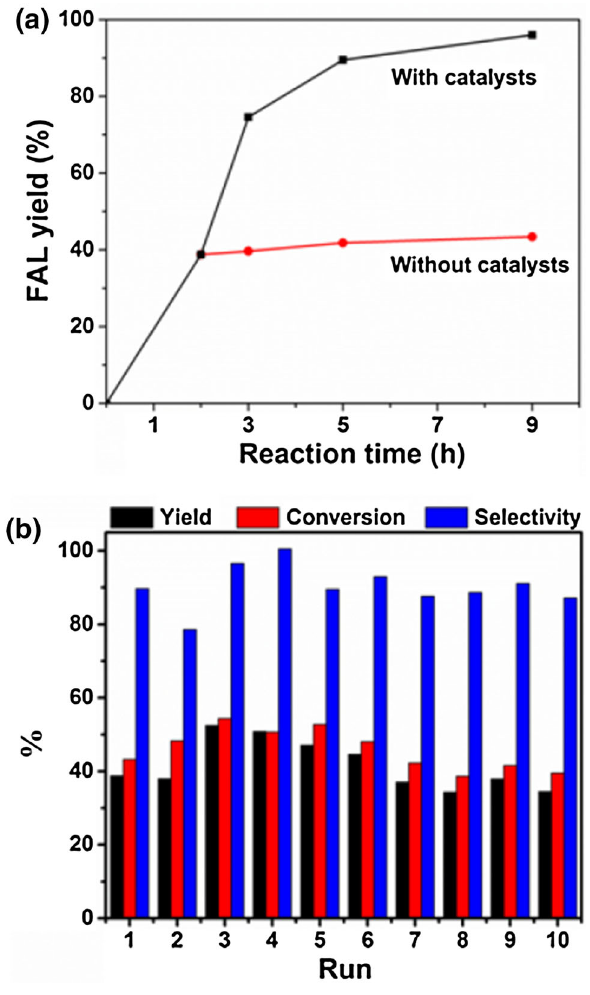
Fig. 5 a Time-yield profiles of the conversion of furfural to FAL, and b Reusability of the catalyst. Typical reaction conditions: furfural 1 mmol, isopropanol 5 mL, Zr-TMSA (1:3:0.75) 200 mg, reaction temperature 70 (cid:3) C. For the reusability, the reaction time was 2